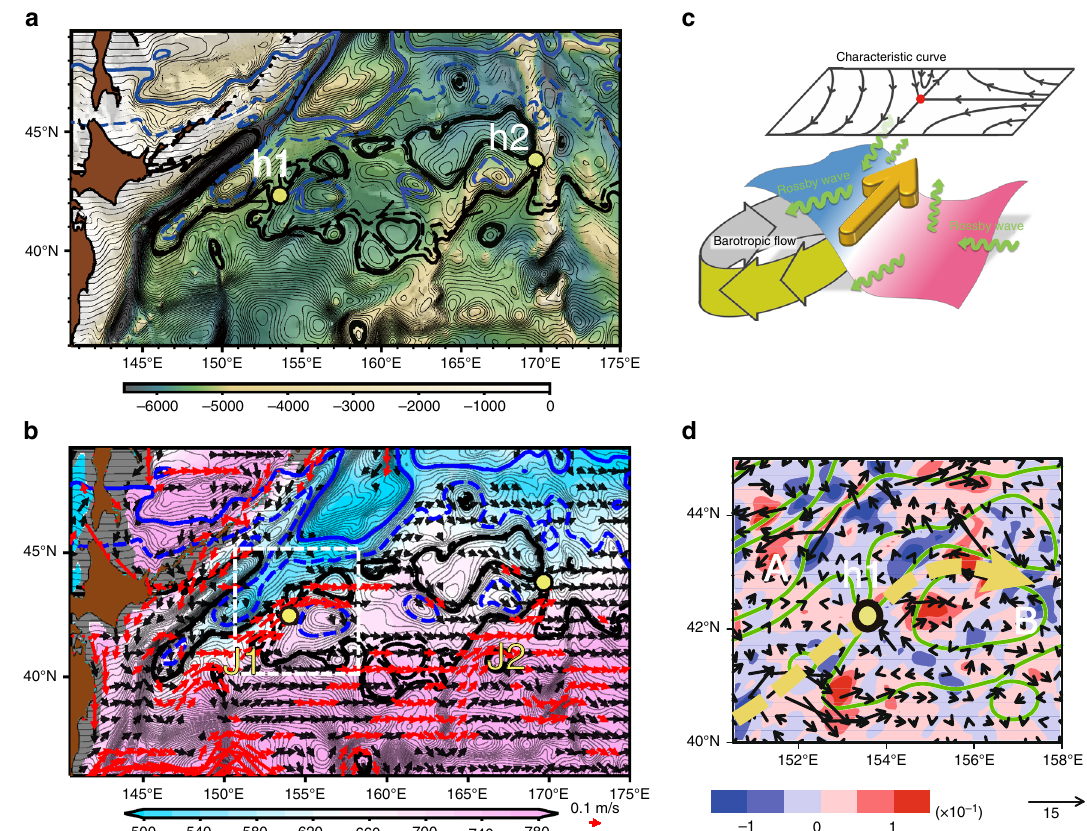
Fig. 4 Surface jet formation and baroclinic Rossby wave characteristic curves. a Characteristic curves and bottom topography. Contours represent Q c given by Eq. (2) evaluated in the western North Paci fi c. The hyperbolic stationary points h1 and h2 associated with J1 and J2, respectively, are denoted by yellow dots. Contour interval is 0.5 × 10 − 6 s − 1 , where thick lines are 4.5 (solid black), 5.0 (dashed black), 8.0 (dashed blue), 12.0 (solid blue) × 10 − 6 s − 1 . Shade represents bottom topography. b Characteristic curves, interfacial depth, and surface current. Contours are Q c , which is the same as those in a . Shade represents isopycnal depth (m) of σ θ = 27.2 derived from JCOPE2 ocean reanalysis. Red (black) arrows denote the surface velocity faster than 0.1 m s − 1 (between 0.1 ms − 1 and 0.05 ms − 1 ) from JCOPE2. Yellow dots denote the hyperbolic stationary points h1 and h2. c Schematic plot representing the relation between characteristic curves and surface jet formation. Shaded distorted plane represents the depth of an isopycnal surface. d Eddy fl ux (vectors; m 2 s − 1 ) adjacent to the J1 and its convergence/divergence (color shade; m s − 1 ) inside the dashed box in b , where convergence is de fi ned to be positive. Speci fi c formulae of the eddy fl ux are given by Eq. (13) in Methods. Eddy thickness fl ux, which is the fi rst term of Eq. (13), dominates over other terms of a factor of 10 2 . Green contours denote Q c with 5.0, 8.0 (×10 − 6 s − 1 ). Yellow dot denotes h1, and yellow arrow denotes a schematic J1 path. Rises A and B are